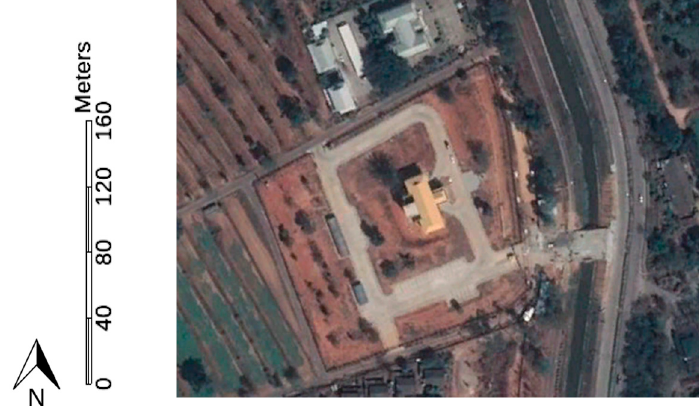
Figure 17. Optical image of the second area in Chiang Mai on 3 March 2018 at 18°51’22.36”N 98°57’40.70”E.